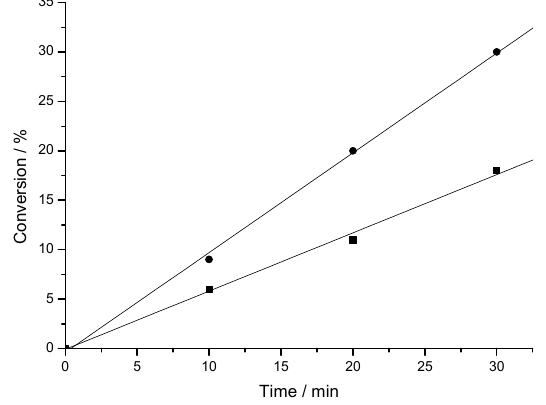
Figure 7. Terpolymerization of DMA, F8H2MA and MAH: time vs. conversion plot for the reaction in MEK ( ▪ ) and MEK:HFX 1:1 vol:vol (•).